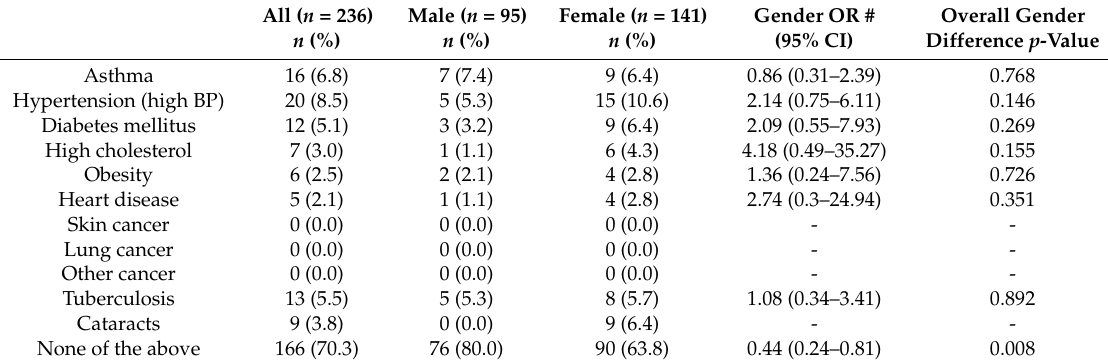
Table 1. Responses to the question, “Have you ever been told by a healthcare professional that you have any of the following conditions?” for all participants and by